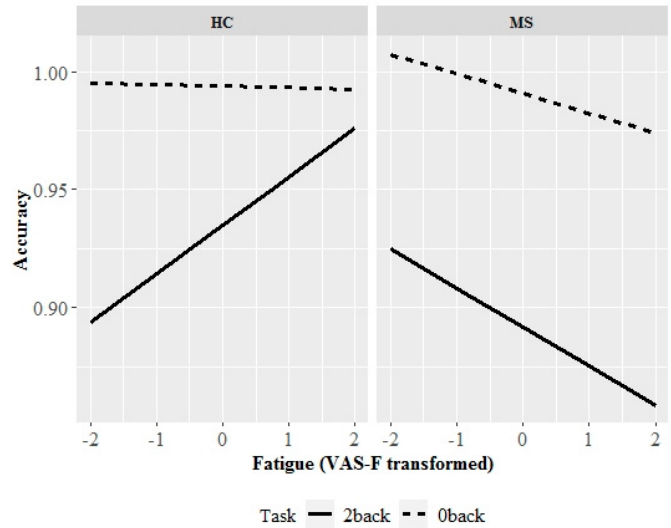
Figure 3. Group × condition × VAS-F (transformed) interaction for n-back task accuracy. For the 2-back condition, there was a positive correlation between fatigue levels and accuracy in the HC group and a negative correlation in the MS group. There were no significant relationships between fatigue levels and accuracy for the 0-back condition. 0-back condition is denoted by dotted lines, and the 2-back condition is denoted by solid lines. Abbreviations: MS, multiple sclerosis. HC, healthy control. VAS-F, Visual Analogue Scale of Fatigue.